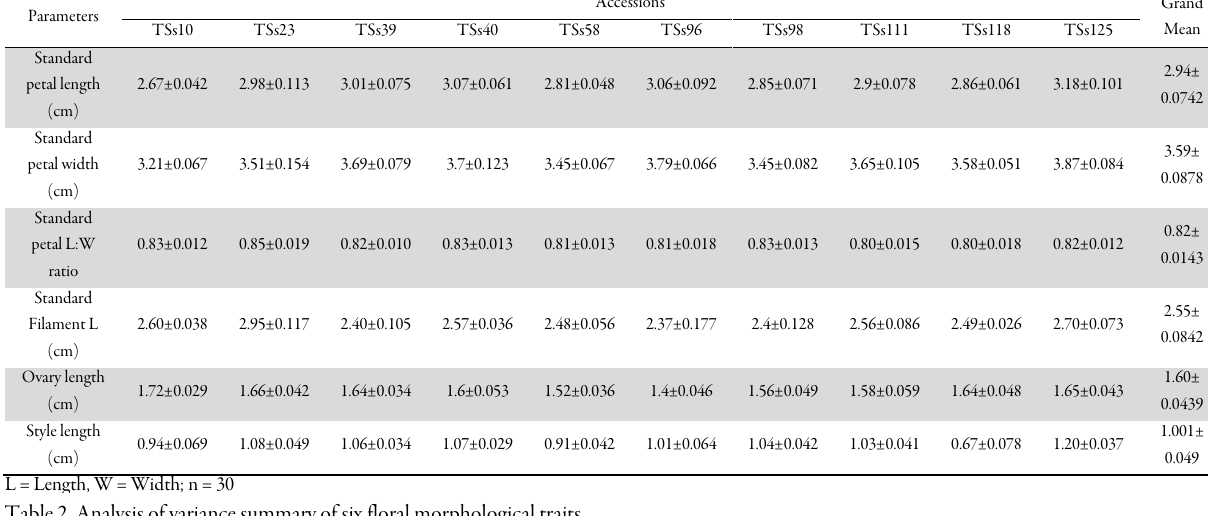
Table 1. The measurements of the floral parts of anthesized flowers of some accessions of African yam bean Parameters